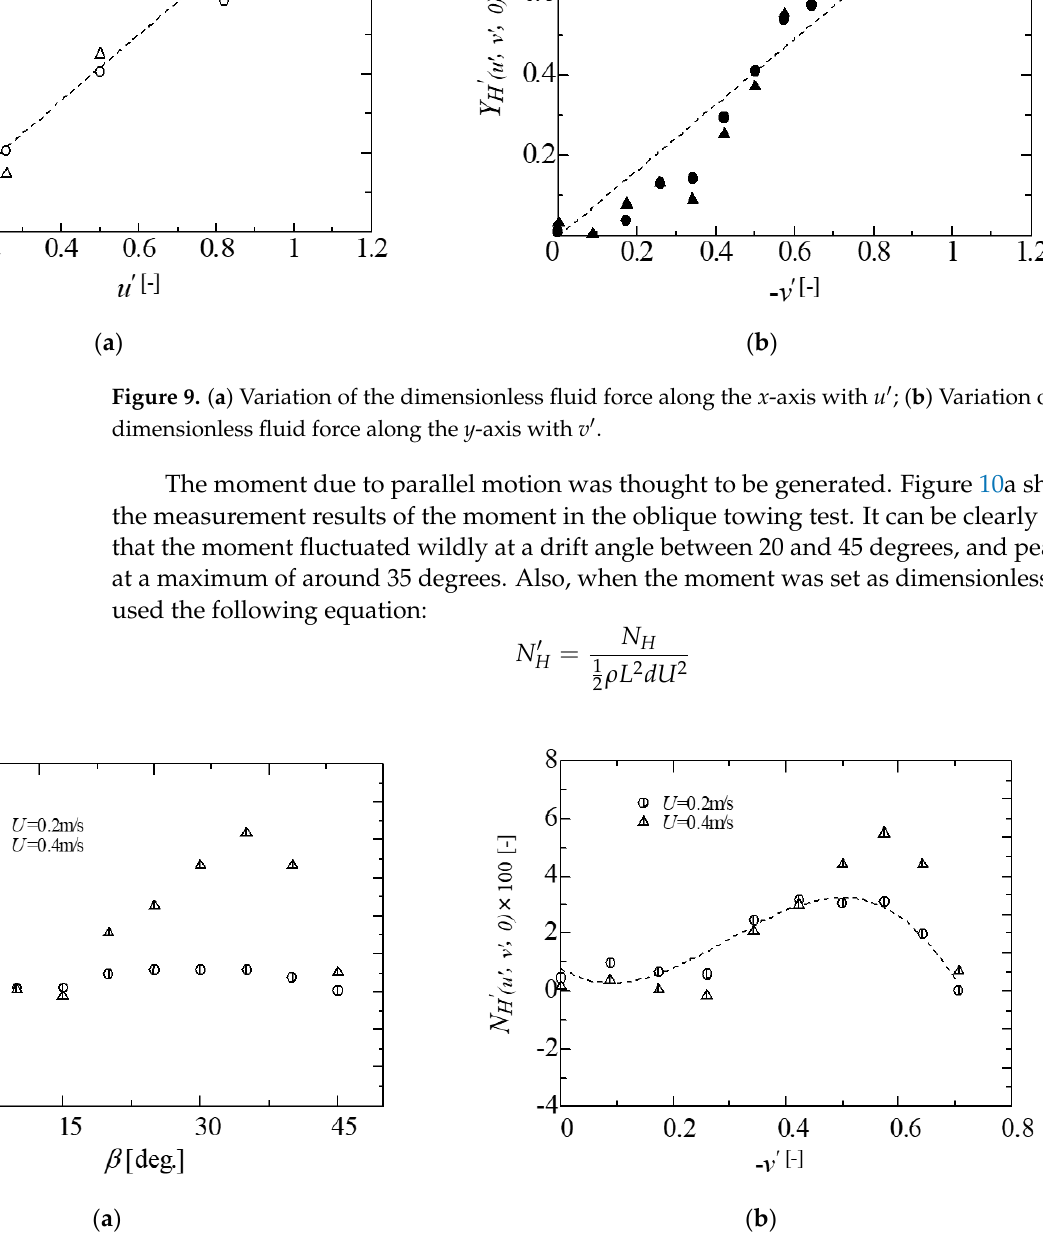
Figure 10. ( a ) Variation of the yaw moment along the z -axis with the drift angle; ( b ) Variation of the dimensionless yaw moment along the z -axis with v ′ .